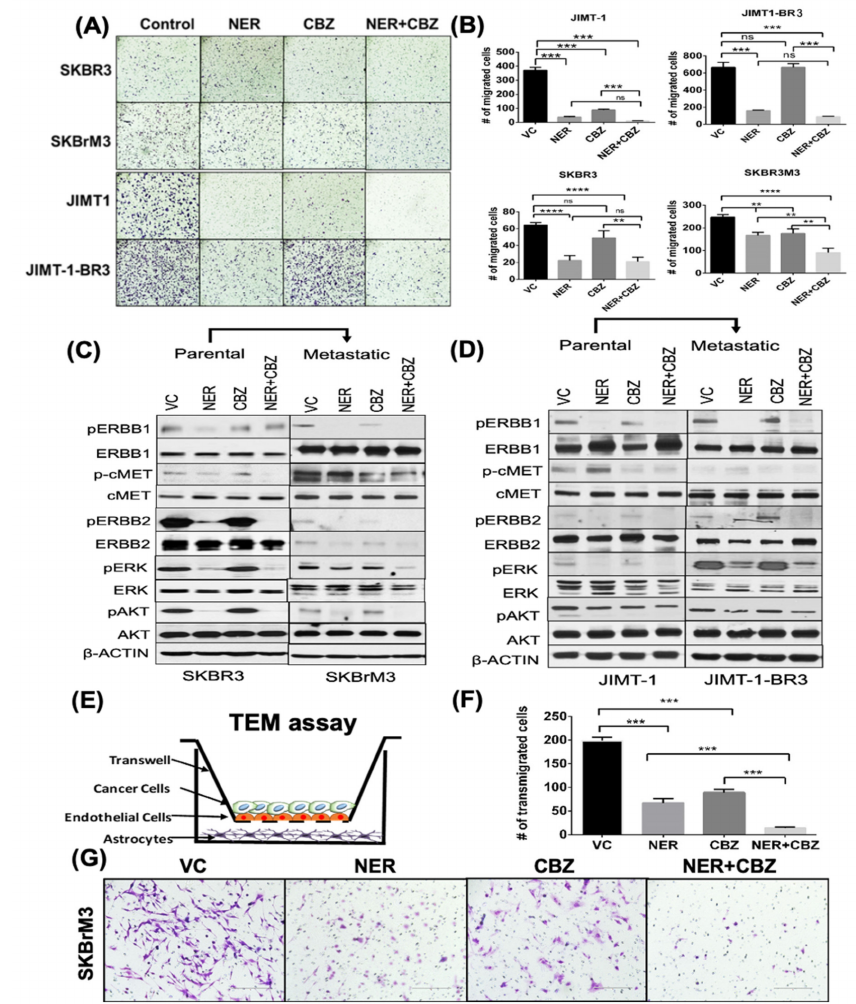
Figure 2. Effect of combination treatment on downstream signaling and in vitro metastatic behavior. ( A , B ) Effect of combination treatment on in vitro migratory potential of SKBrM3 and JIMT-1-BR3 cell lines. Brain-seeking BC cell lines SKBrM3 and JIMT-1-BR3 and their respective parental cell lines SKBR3 and JIMT-1 were treated with NER (1 µ M), CBZ (5 µ M), or their combination. Cells that migrated